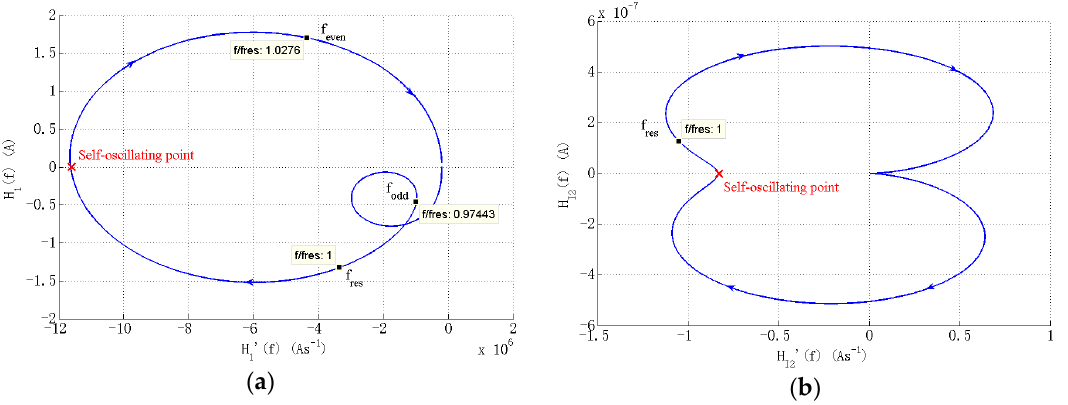
Figure 5. Hamel loci when C 2 increases: ( a ) feedback variable i 1 ; and ( b ) feedback variable i 2 with an